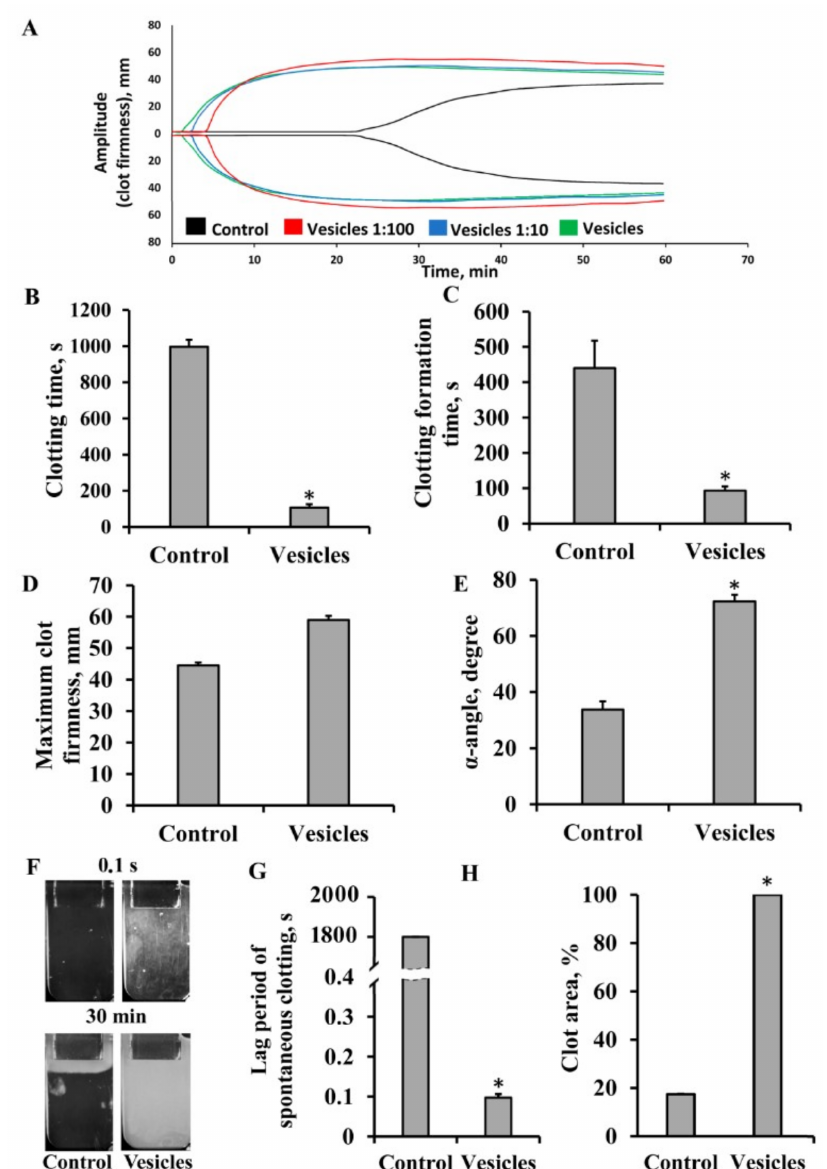
Figure 4. Procoagulant activity of MSC-derived extracellular vesicles in whole blood and platelet-free plasma (PFP). EVs were obtained from conditioned medium of MSCs and added to blood or PFP. Vesicle concentrations were 4.3 × 10 10 (marked as vesicles), 4.3 × 10 9 (marked as 1:10), and 4.3 × 10 8 (marked as 1:100) particles per mL of blood. Data from the NATEM test (A–E) and thrombodynamics (TD) assay (F–H). ( A ) Representative thromboelastometry diagram of dose-dependent effects of EVs on blood coagulation. ( B ) Clotting time, ( C ) clot formation time, ( D ) maximum clot firmness, and ( E ) alpha-angle assayed by the NATEM test. ( F ) Representative screenshots at 0.1 s and 30 min of TD videos showing clotting formation in PFP after addition of EVs. ( G ) Lag period of spontaneous clot formation and ( H ) clot area calculated in % from the full volume of the cuvette at the end of the thrombodynamics test. Blood from five donors was used, and each blood sample was incubated with MSCs obtained from three different umbilical cord samples. Data reported as mean ± standard error of the mean (SEM). * p < 0.05, Student’s t